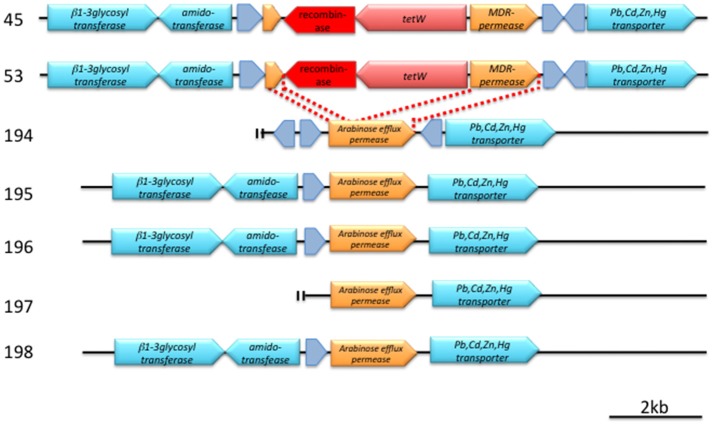
Detailed structure of a conserved genetic region around tetW (pink arrow) and a putative recombinase (red arrow). Hypothetical proteins are indicated by gray arrows. Annotation was made according to SEED. Bar indicates 2 kb length. For details, see text and Figure S1.